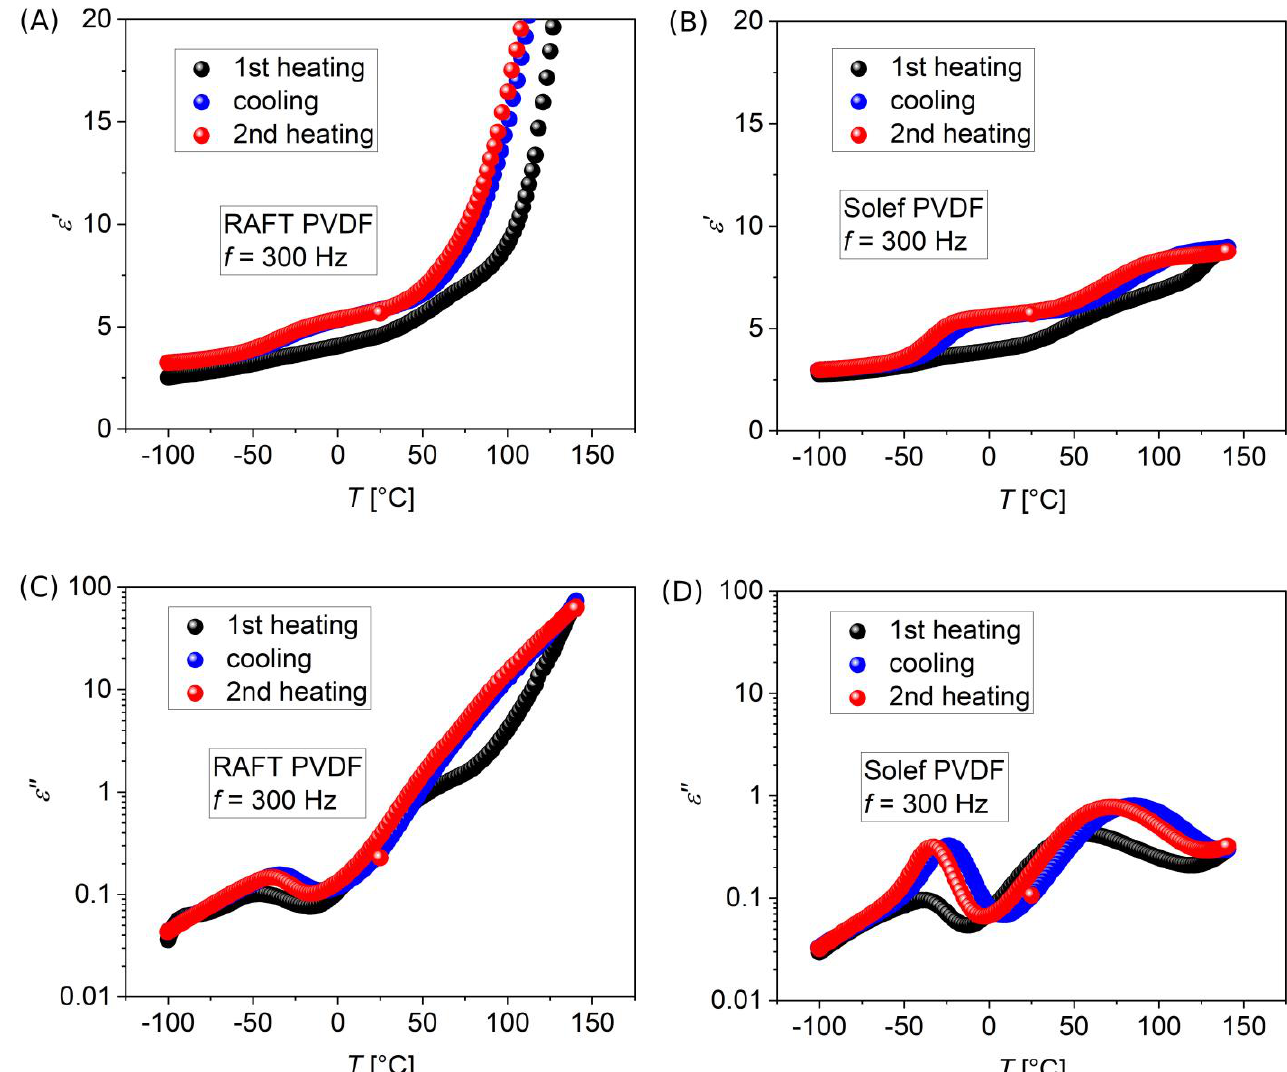
Figure 5. Isochronal dielectric spectra showing the dielectric permittivity (real part ε ′ ( A , B ) and imaginary part ε ″ ( C , D )) at the frequency of 300 Hz during a temperature ramp from −100 °C to 140 °C (black circles, first heating, at 10 °C/min), successive cooling down to −100 °C at the same rate (blue circles), and second heating up to 140 °C at the same rate (red circles). ( A , C ) PVDF sample obtained by RAFT polymerization (RAFT); ( B , D ) Commercial high molar mass PVDF (Solef). Peak values of ε ″ of the lower temperature process, around T g , reported in the relaxation plot of Figure 4, were derived from ( C , D ) as well as from the similar measurements at 10 Hz and 10 kHz (reported in Figure S3 of the Supplementary Materials).